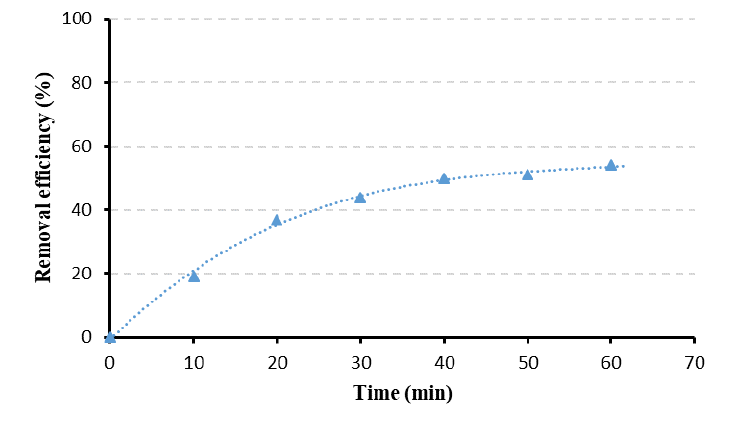
Fig. 2. Effect of treatment time on COD